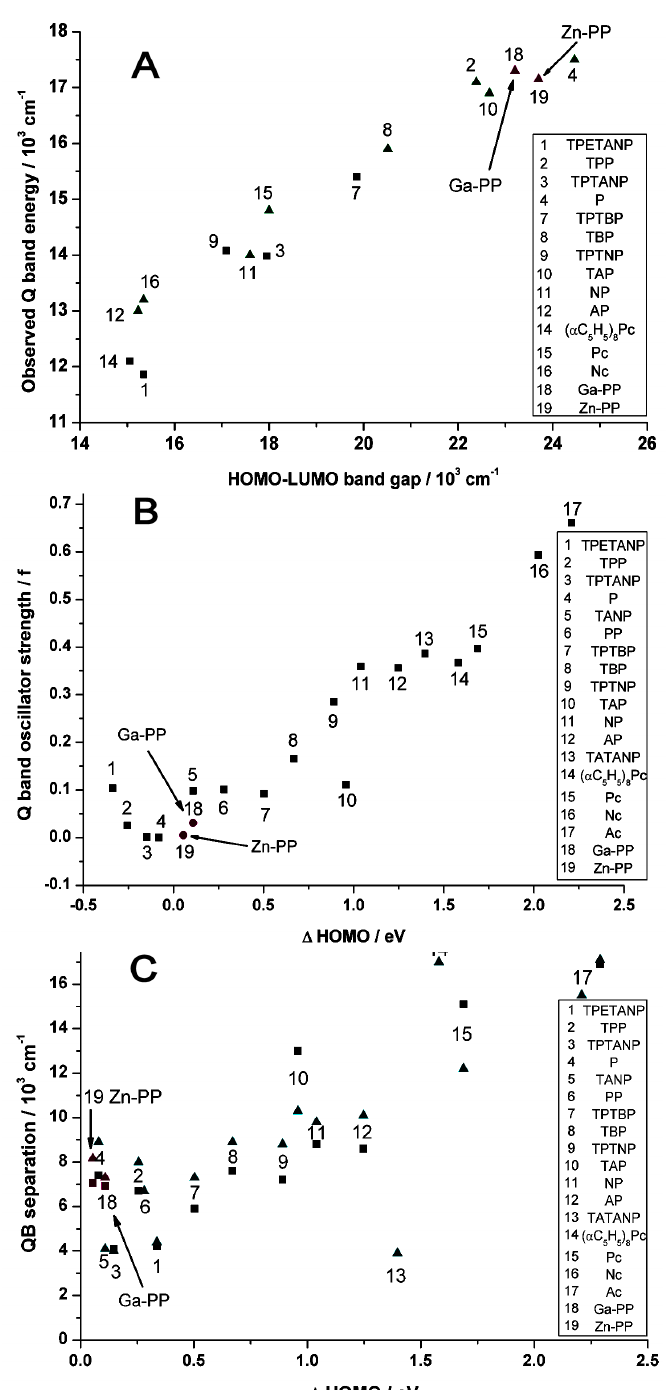
Figure 9. Trends in optical properties as a function of the energies of the four "Gouterman" orbitals. ( A ) Energy of the Q-band as a function of Δ (LUMO–HOMO); ( B ) Q-band oscillator strength (f) as a function of Δ (“HOMO”) or Δ {(HOMO) − (HOMO − 1)}; ( C ) Q-B energy gap as a function of Δ (“HOMO”) or Δ {(HOMO) − (HOMO − 1)}. (Key: Molecular structures of the zinc complexes of porphyrin (P), tetraazaporphyrin (TAP), tetraphenyl-porphyrin (TPP), tetrabenzoporphyrin (TBP), phthalocyanine (Pc), tetraphenyltetrabenzoporphyrin (TPTBP), naphthoporphyrin (NP),